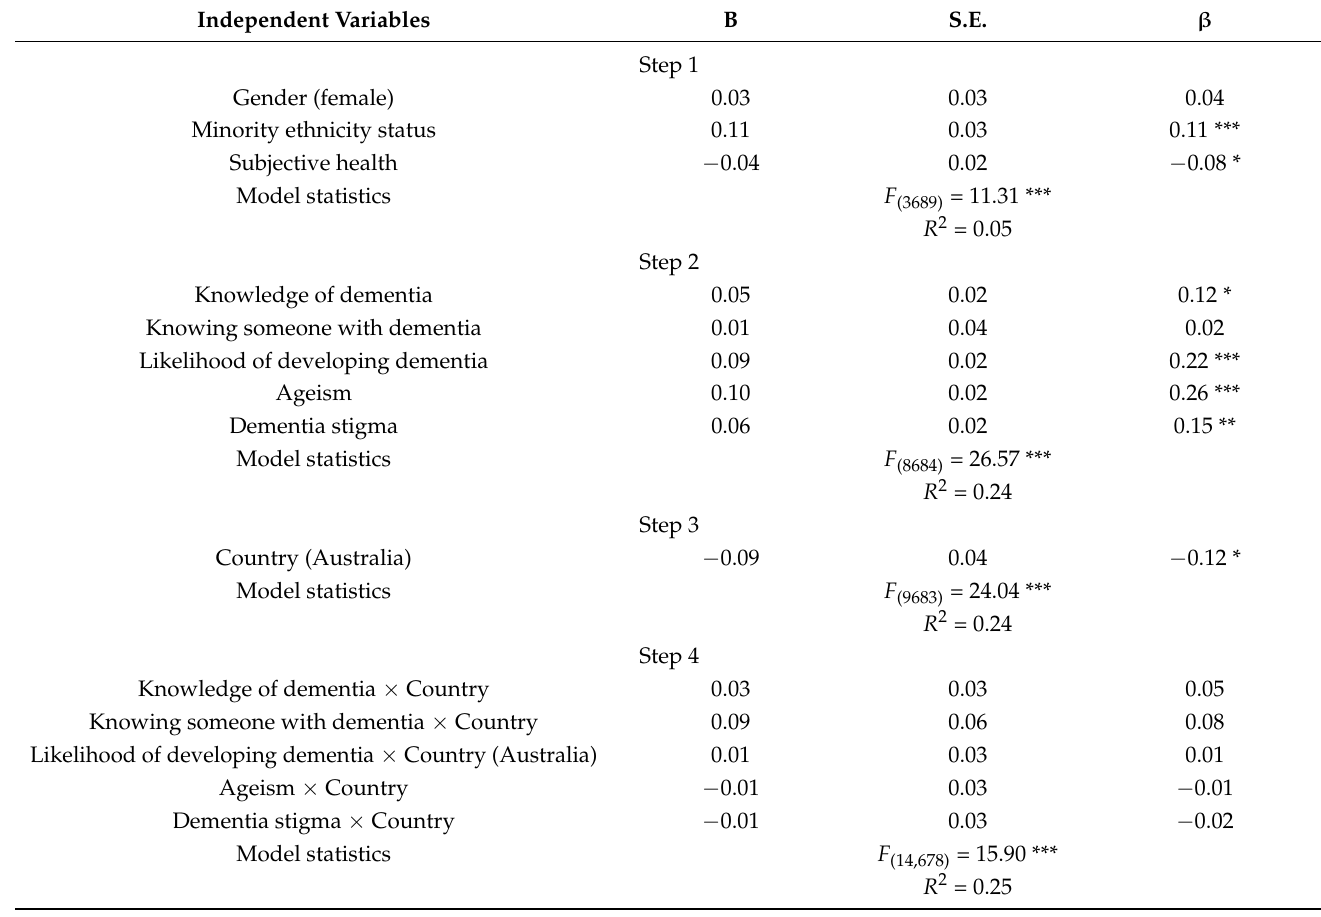
Table 2. Linear regression for dementia worry and its